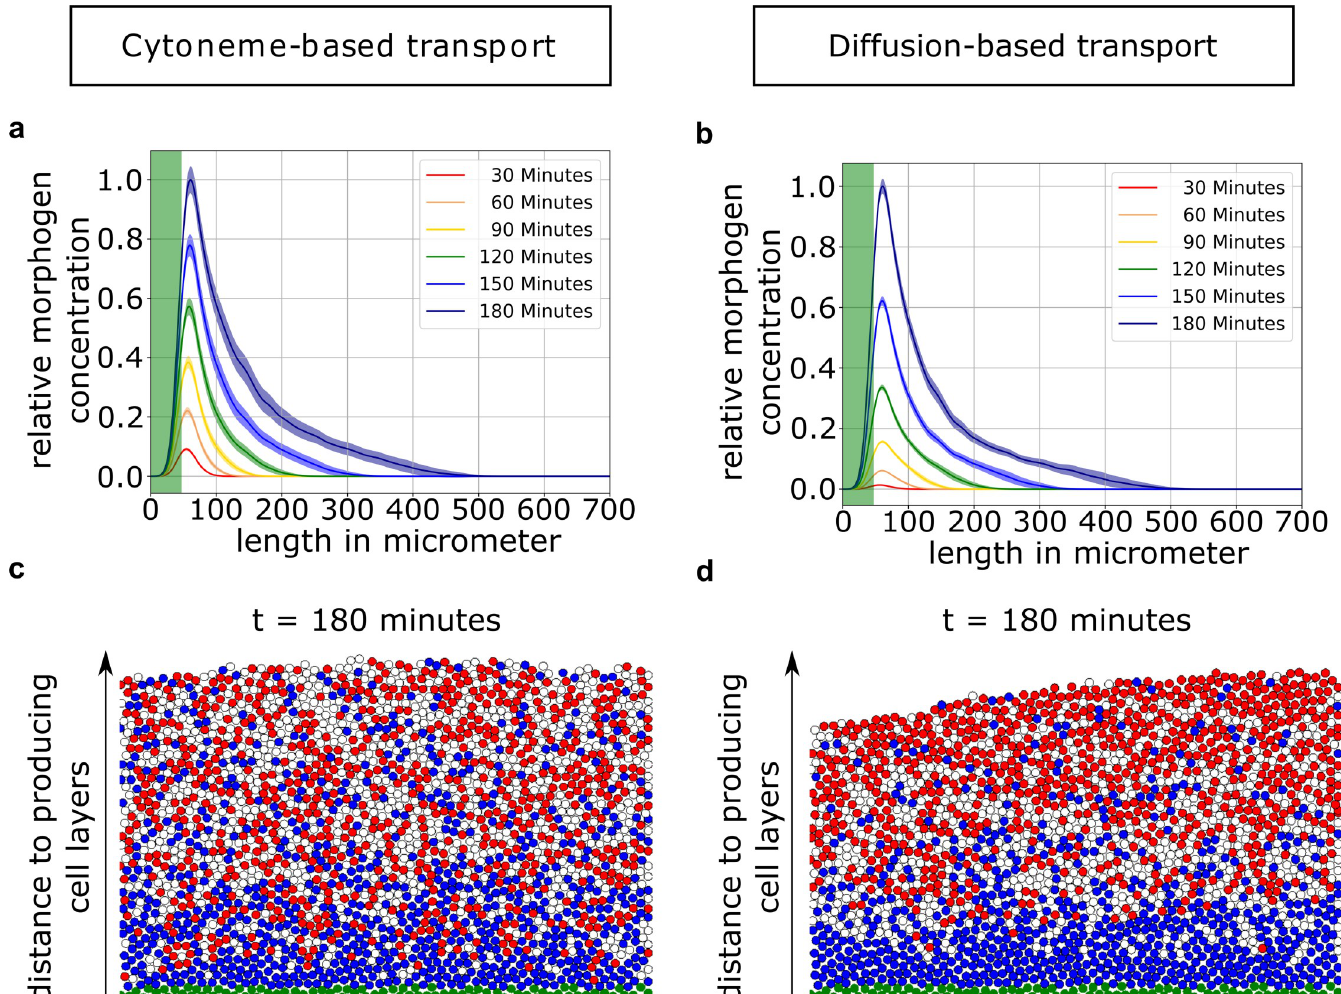
Fig 1. Comparison of cytoneme-based and diffusion-based Wnt transport. a) and b) show the mean gradient of Wnt concentration (100 simulations) with standard deviation in transparent over the expanding tissue at different times (normalized to the maximum at t = 180 min) with respect to the distance from the embryonic margin, the green area indicates Wnt producing cells. c) and d) show the corresponding 2D cell distribution at the final stage ( t = t TRS = 180 min). Cell fates are determined by thresholds on the local single cell Wnt-concentration. The thresholds are set at t = 180 min so that the cell-numbers in forebrain-, midbrain- and hindbrain-fate are equal. Besides the Wnt producing cells shown in green, the colors of the cells represent different cellular fates: forebrain fate is indicated in red, midbrain fate in white and hindbrain fate in